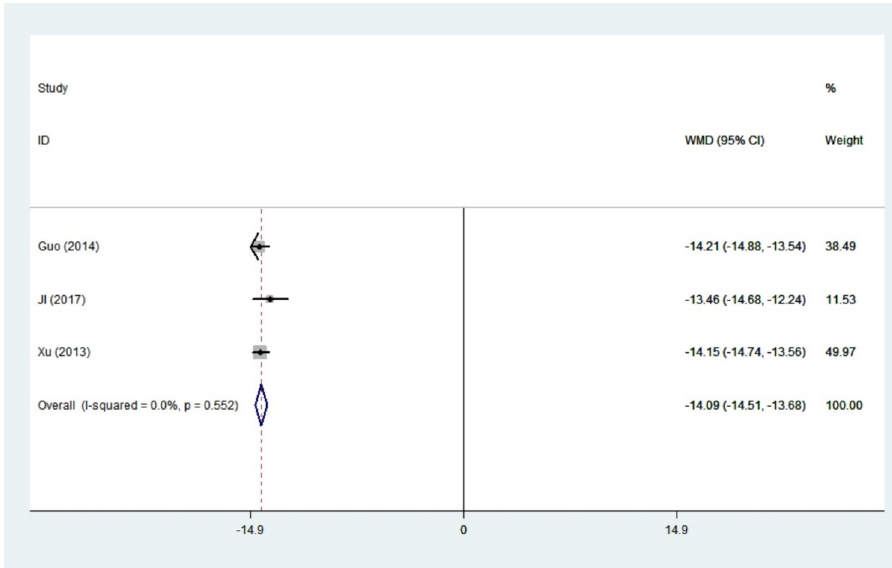
Fig 7. Forest plots of showing the effects of PTU on